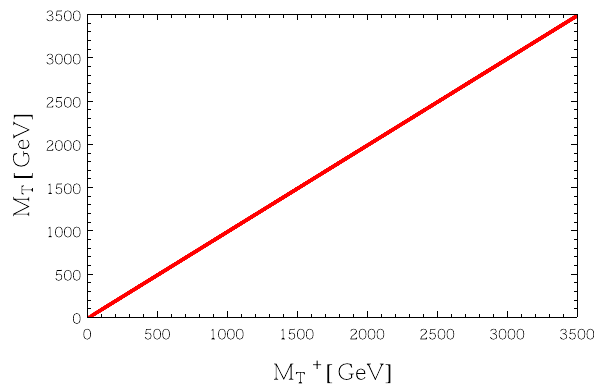
Fig. 3 Variation of M ± mass-splitting and the width describes the different solutions allowed by parameter